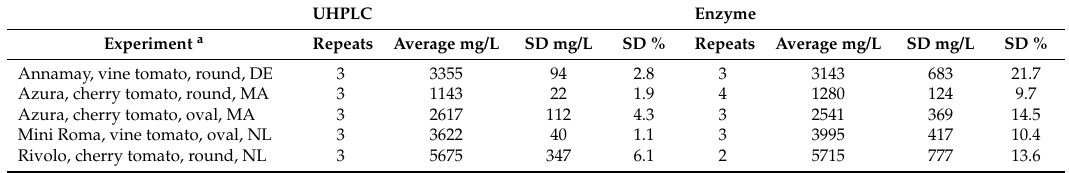
Table A1. Analysis of glutamate in different tomato cultivars by UHPLC and an enzymatic test. UHPLC